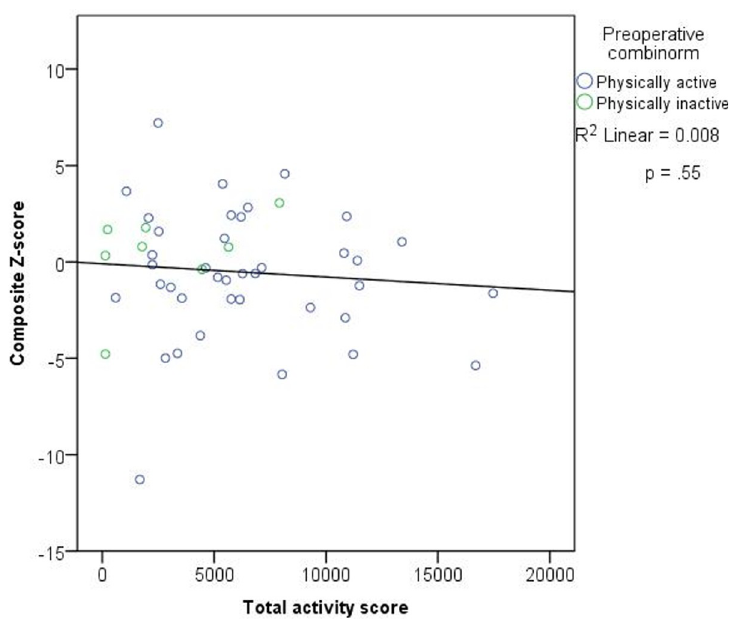
Fig 4. Total activity scores and composite Z-score. A linear regression model for total activity score and composite Z-score. There was no significant relationship p = .55. Active (blue) and inactive (green) patients have also been distinguished (n =